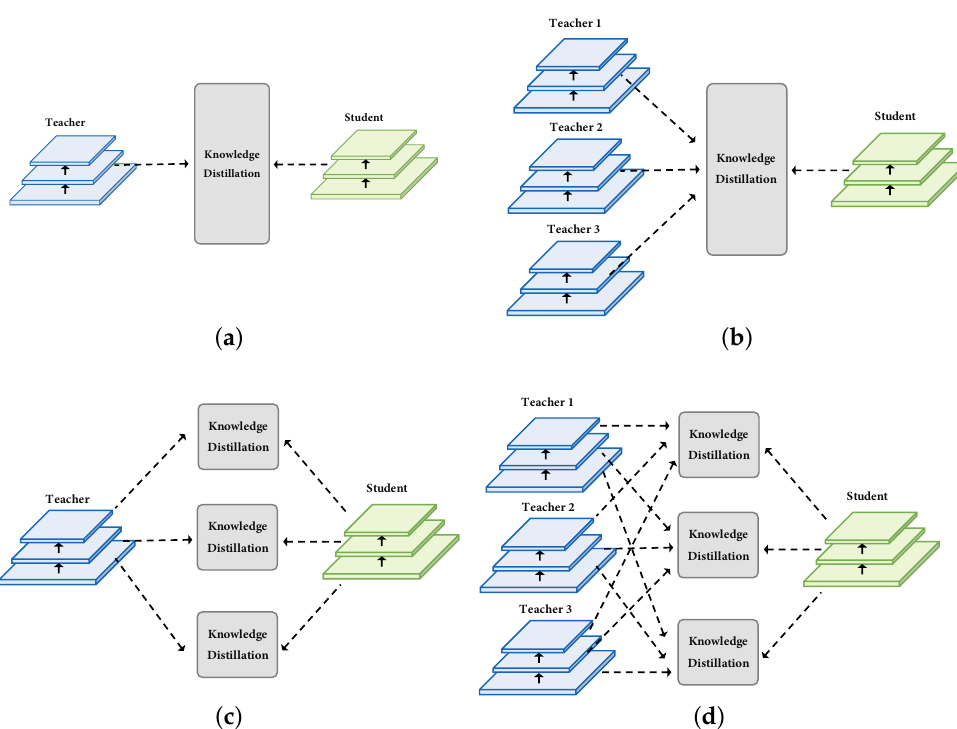
Figure 4. Four different distillation strategies. Due to the varied knowledge from different teachers and different stages, dense multi-teacher knowledge distillation can typically offer rich knowledge and fine-tune a better student model. ( a ) Sparse mono-teacher distillation, ( b ) sparse multi-teacher distillation, ( c ) dense mono-teacher distillation, ( d ) dense multi-teacher distillation. Homogeneous Feature Representation Learning